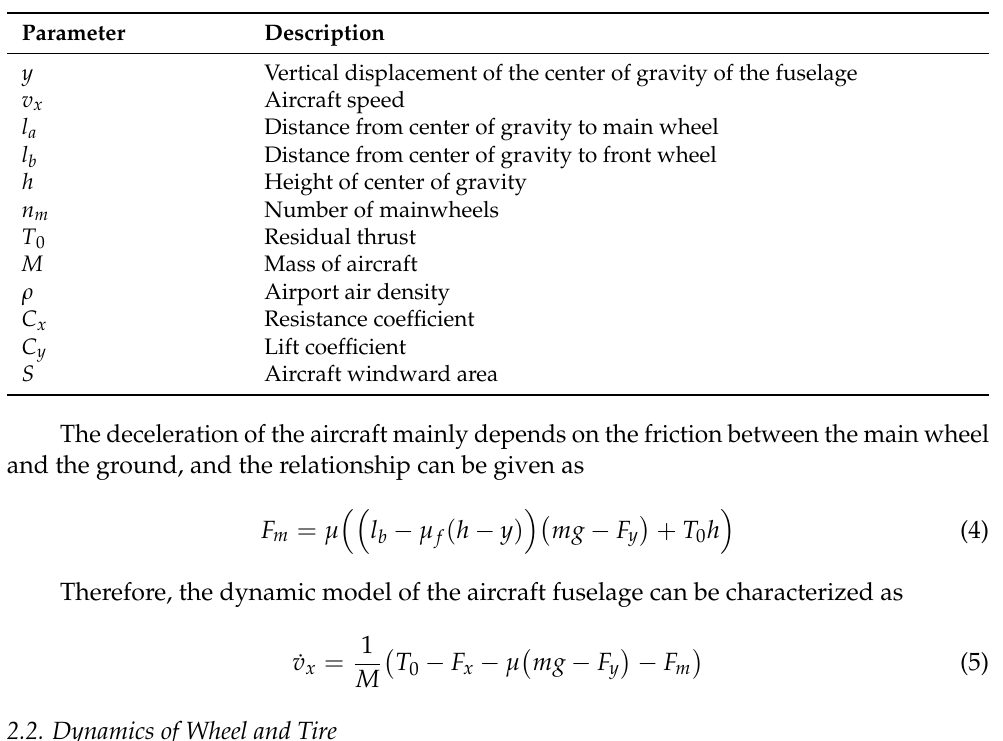
Table 1. Aircraft parameters.